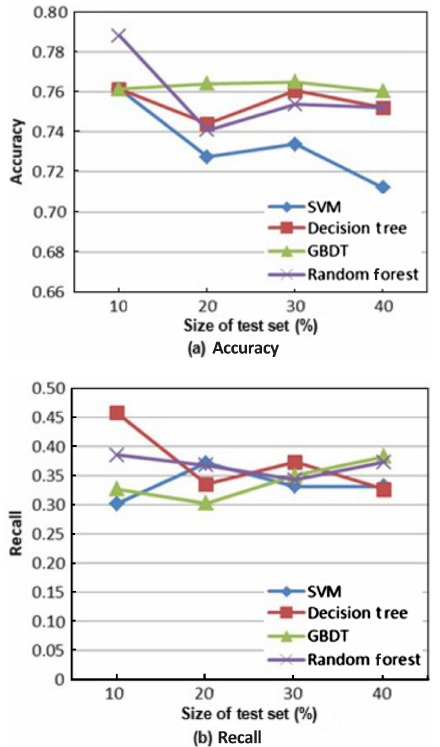
Fig. 5 Accuracy and recall of the three-layer model.